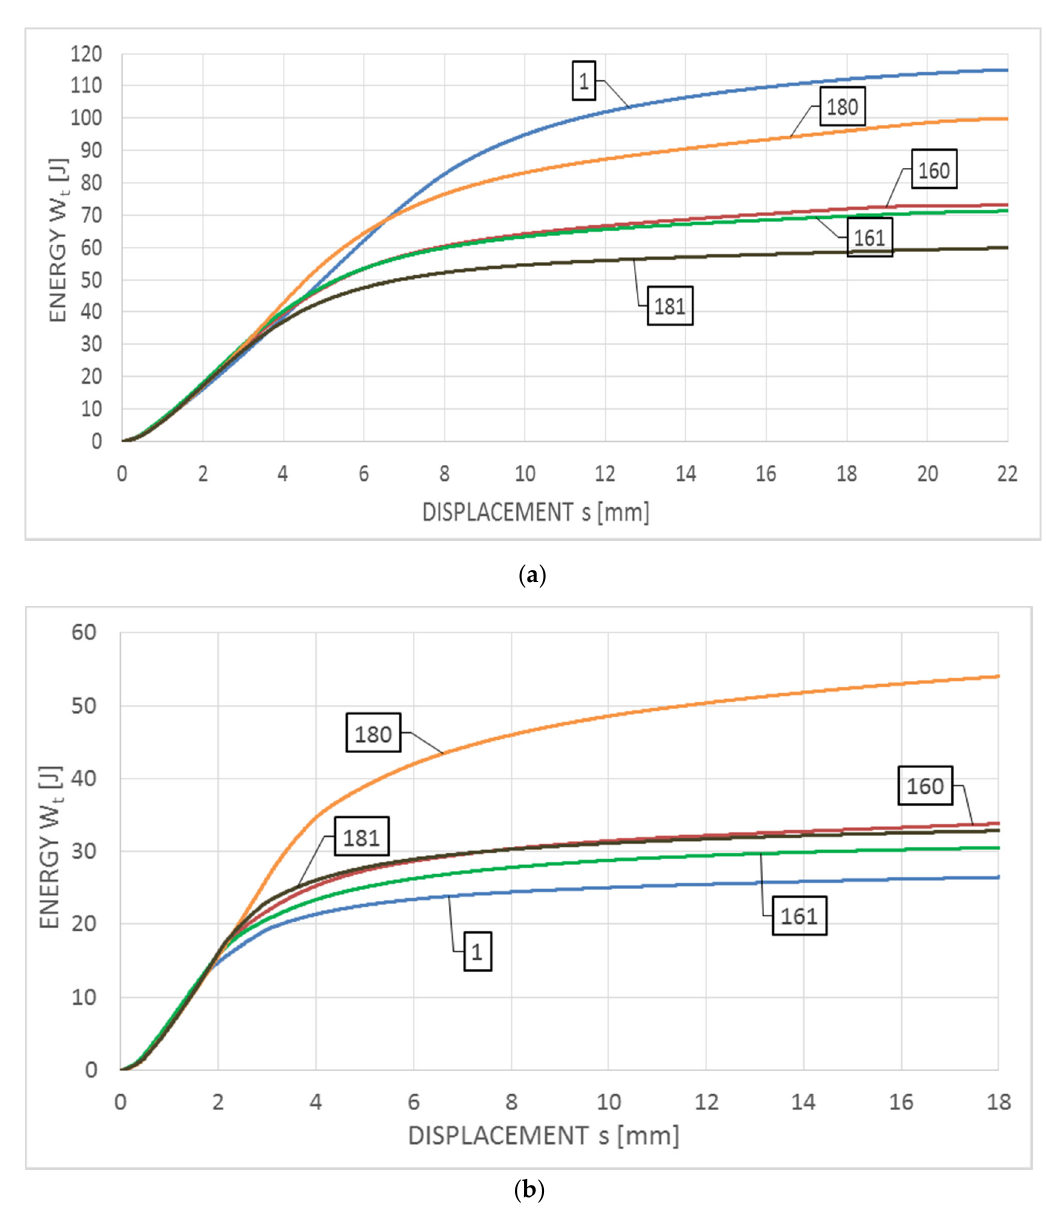
Figure 9. Averaged 𝑊 (cid:3047) − 𝑠 curves obtained on samples made of S355J2+N steel: ( a ) during tests conducted in +20 °C, ( b ) during tests conducted in − 20 °C.